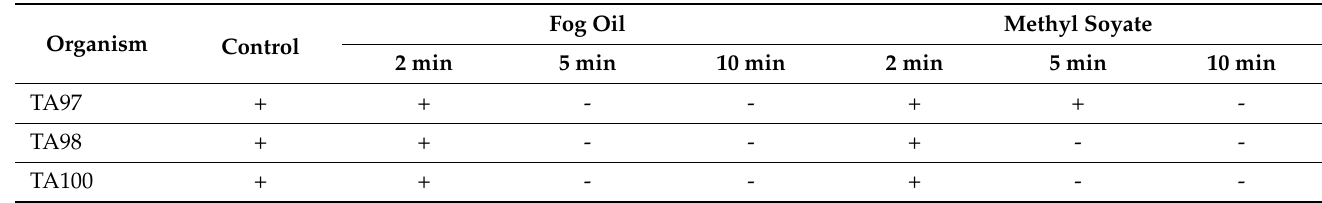
Table 6. Exposure results of plates covered with stationery paper with a hole in the center.